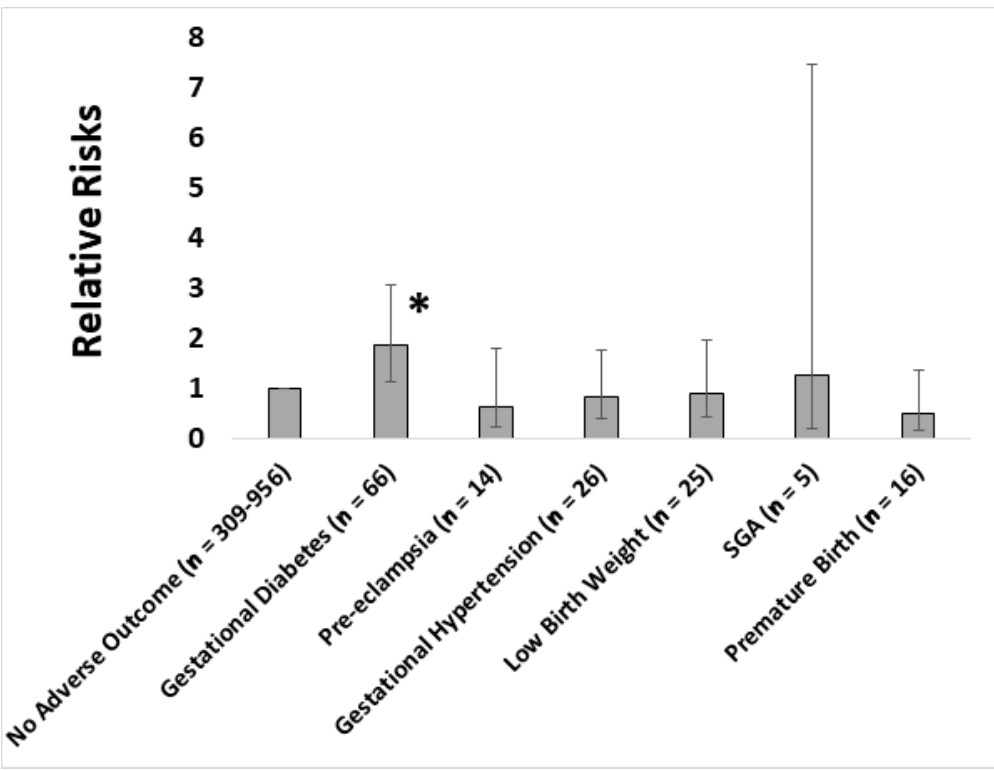
Figure 1. Relative risks of various adverse conditions of pregnancy in women who supplemented their diets with multiple micronutrients in pregnancy (* p < 0.05).